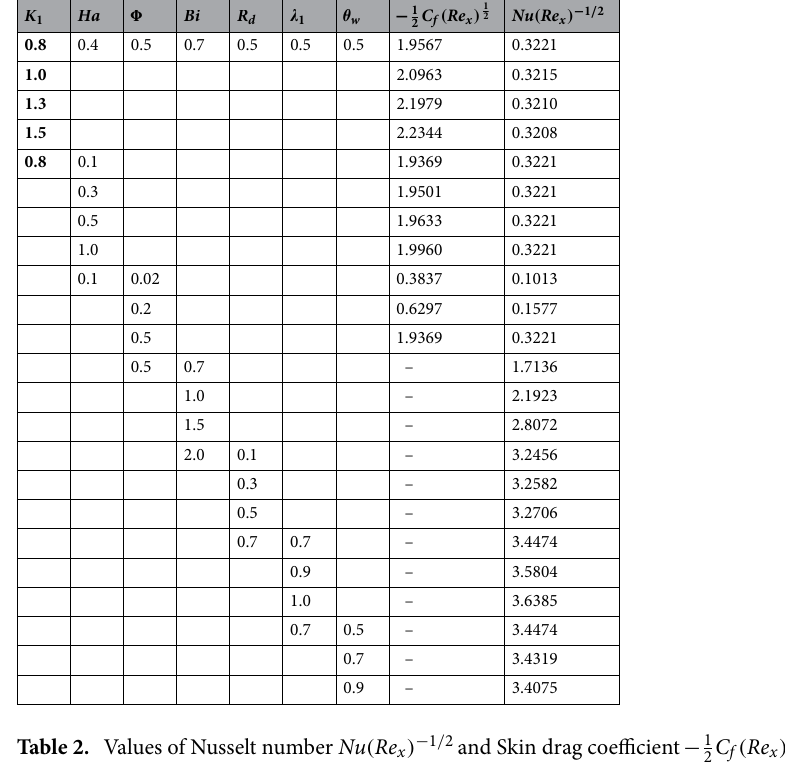
Table 2. Values of Nusselt number Nu ( Re x ) −